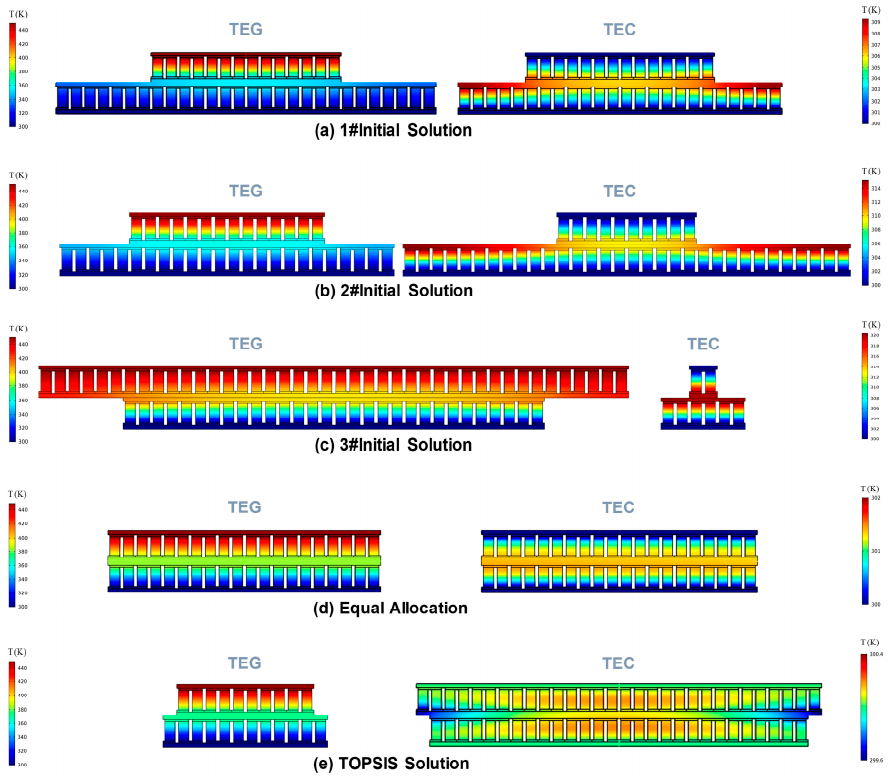
Figure 12. Temperature profiles of different allocation design: ( a ) 1# Initial Solution; ( b ) 2# Initial Solution; ( c ) 3# Initial Solution; ( d ) Equal Allocation; and ( e ) TOPSIS Solution.